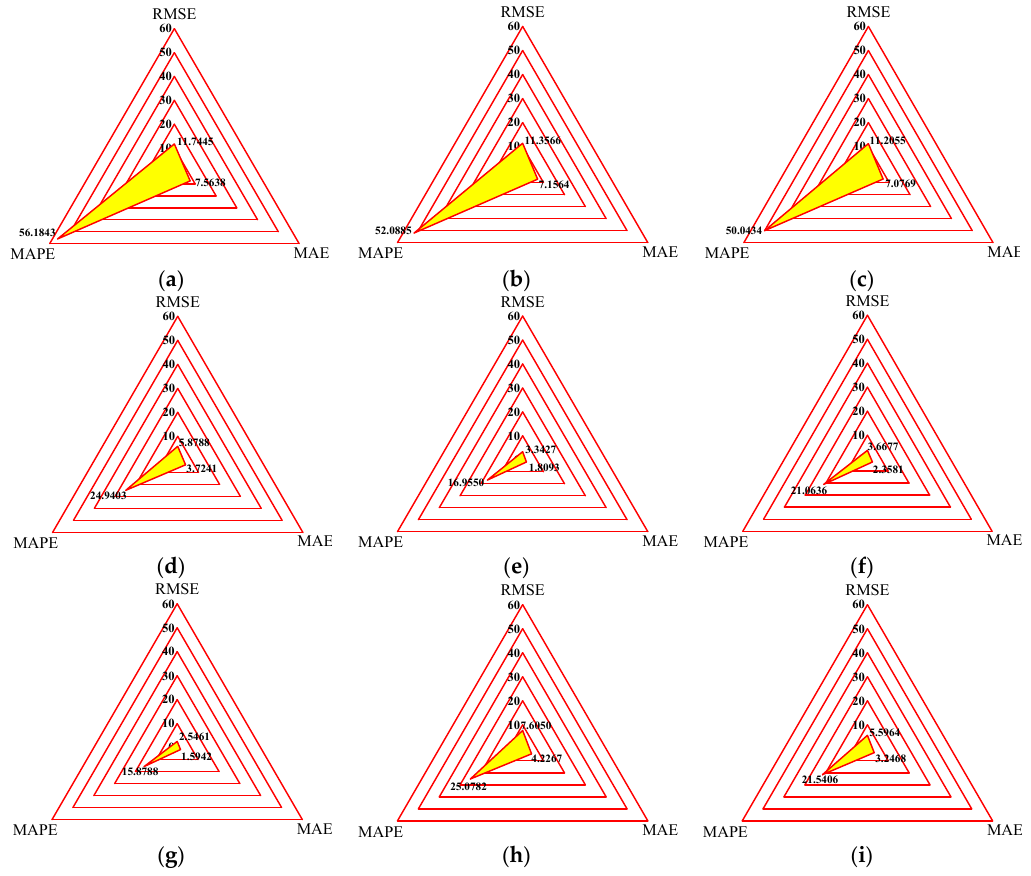
Figure 32. Statistical evaluation indices of phenomenological models. ( a ) Kelvin–Voigt model, ( b ) four-parameter viscoelastic model, ( c ) rheological model, ( d ) BW model, ( e ) improved BW model, ( f ) Dahl model, ( g ) improved LuGre friction model, ( h ) strain stiffening model, ( i ) hyperbolic hysteresis model.